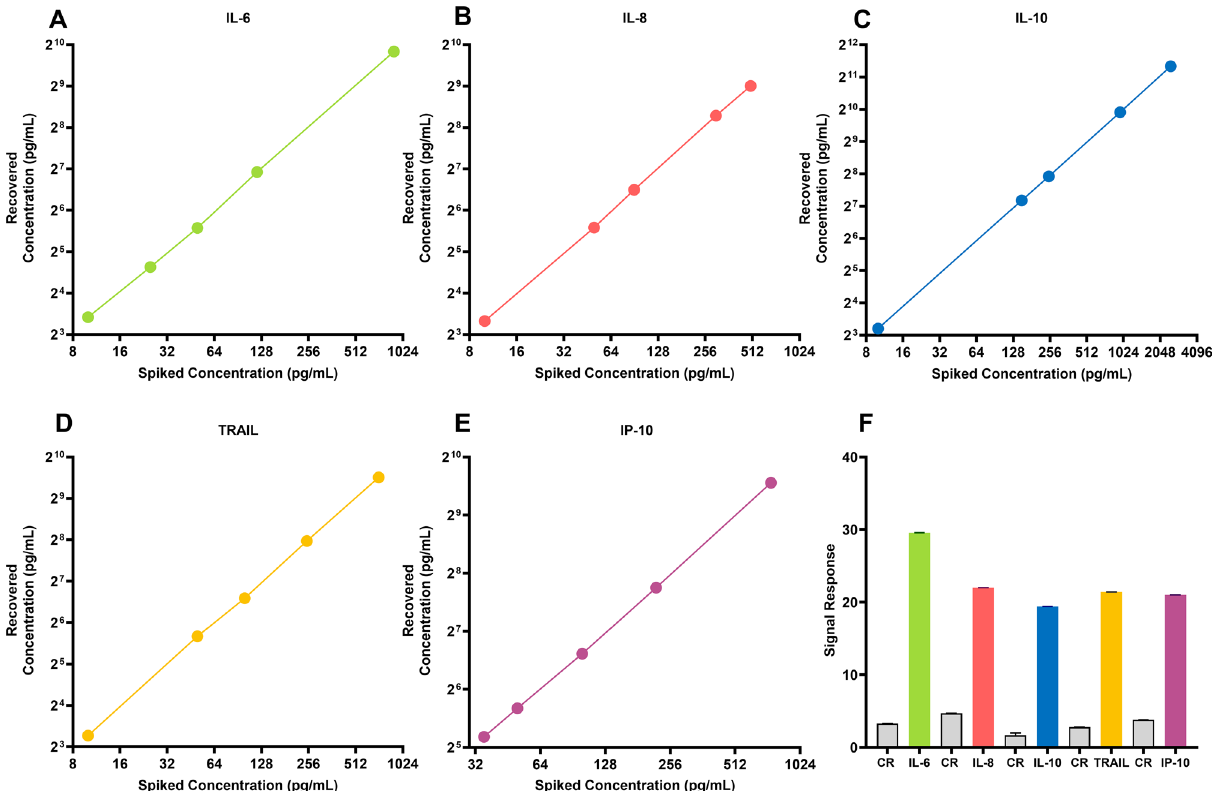
Figure 2. ( A – E ) Spike and recovery analysis using READ platforms for all the study biomarkers with a wide dynamic range. ( F ) Cross-reactive (CR) study demonstrates the specificity of the READ sensor platform for IL-6, IL-8, IL-10, TRAIL and IP-10. Data represented in the graphs with n = 3